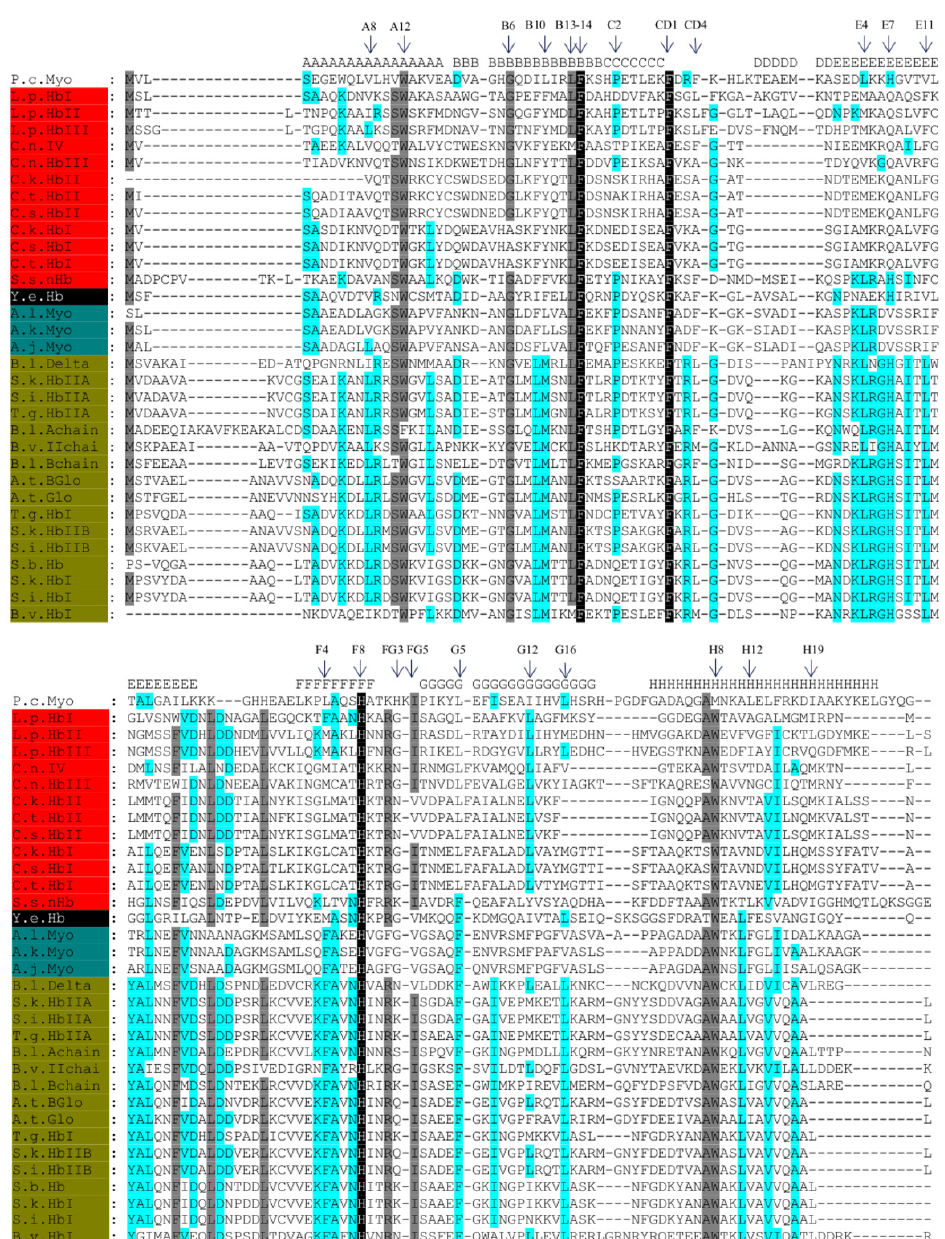
Figure 2. GeneDoc visualization of Multiple Sequence Alignment of 32 mollusk protein sequences using PSI-COFFEE. The conservation is shown in three levels based on similarity groups: Black for 100% conservation, Gray for 75% of conservation and light blue for 50% conservation. The abbreviations are the following: L.p ( L. pectinata ), C.n. ( C. nautilei ), C.k. ( C. kaikoi ), C.t. ( C. tsubasa ), C.s. ( C. soyoae ), B.l. ( Barbatia lima ), S.s. ( Spisula solidissima ), Y.e. ( Y. eightsi ), A.l. ( Aplysia limacine ), A.k. ( Aplysia kurodai ), A.j. ( Aplysia juliana ), S.k. ( Scapharca kagoshimensis ), S.i. ( Scapharca inaequivalvis ), T.g. ( Tegillarca granosa ), B.v. ( Barbatia virescens ), A.t. ( Anadara trapezia ), S.b. ( Scapharca broughtonii ), and P.c. ( P. catodon ). On top of the